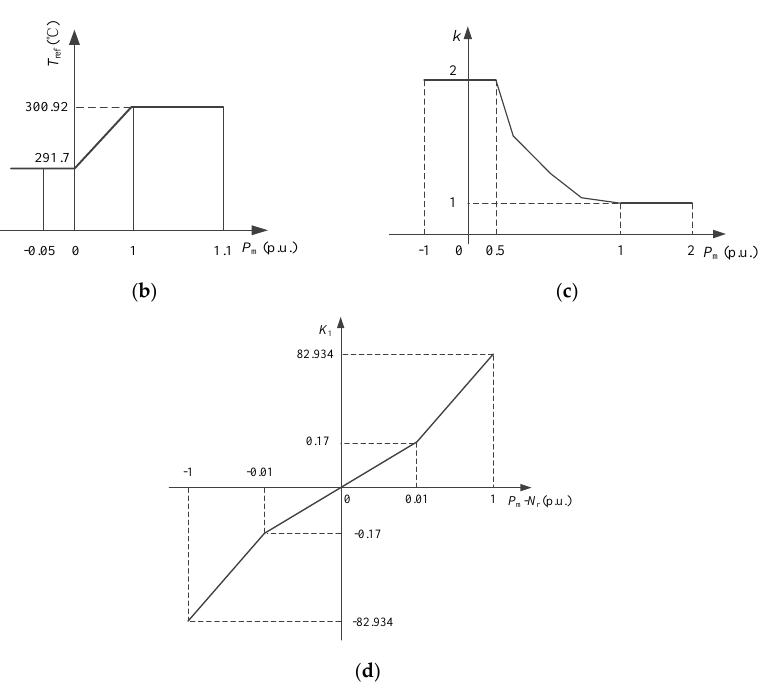
Figure 2. Reactor power control system module. ( a ) Reactor power control system diagram; ( b ) average temperature link; ( c ) variable amplification link; and ( d ) nonlinear amplification link. T ref is the given temperature value for the reactor.